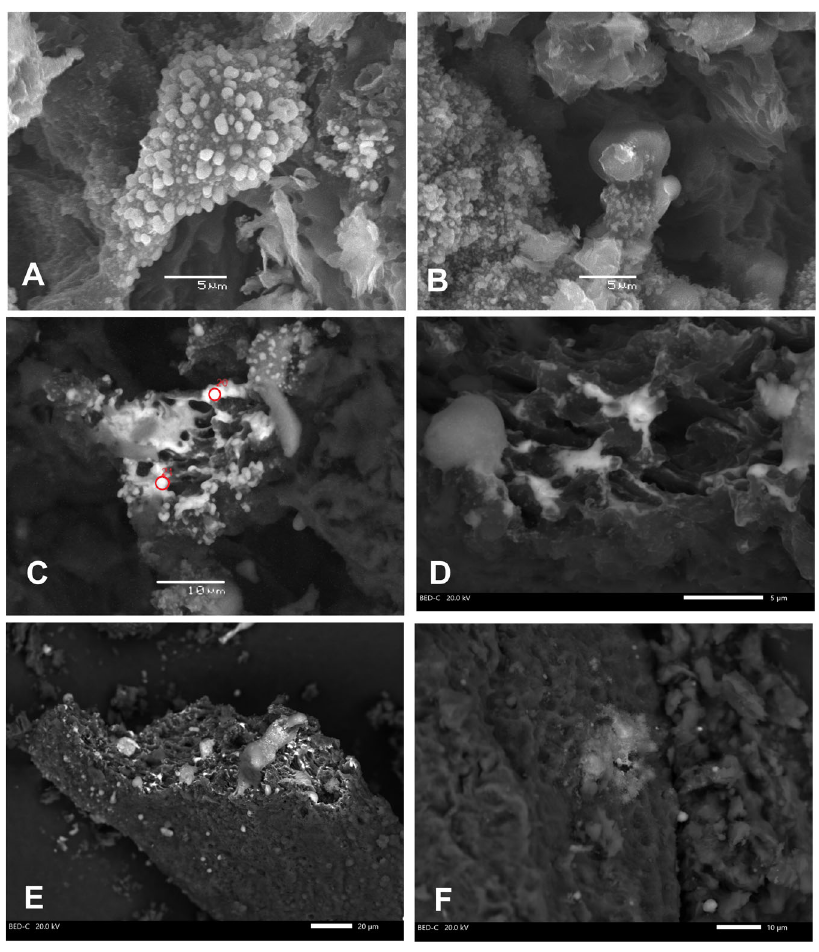
Fig. 6 Scanning electron microscopy of the graphite sample. Blue circles indicates some analysis spots with fuel debris, Red ones — pure aluminosilicates. Scale bars: 5 µm in ( A , B , D ); 10 µm in ( C , F ); 20 µm in ( E